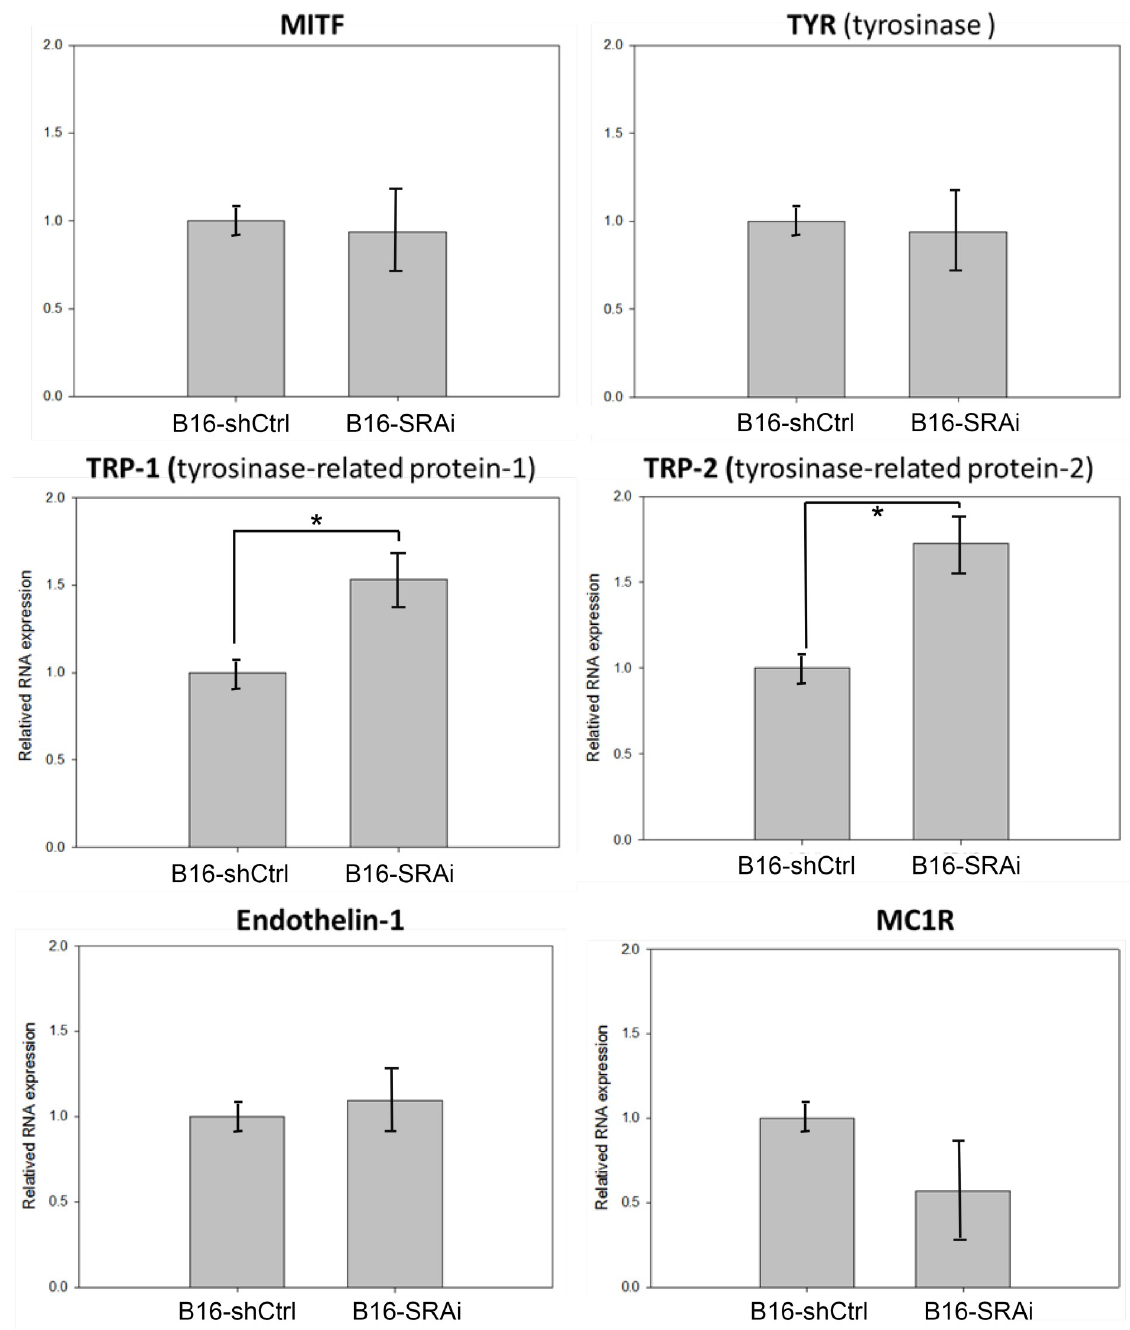
Fig 2. Increased TRP1 and TRP2 expressions in SRA-deficient B16 cells. B16-shCtrl and B16-SRAi cells were processed for RNA extraction, cDNA synthesis, and real-time PCR for the measurement of MITF, TYR, TRP1, TRP2, endothelin-1, and MC1R (n = 3 and 3, respectively; error bars represent standard errors; � indicates p <